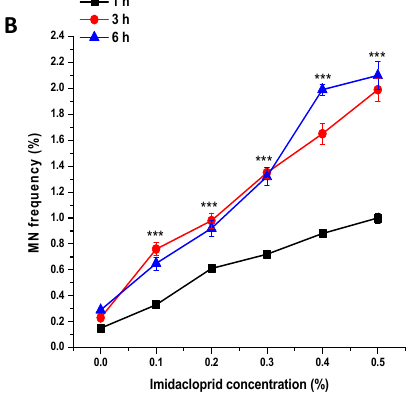
Figure 6. Micronucleus frequency in pollen-mother cells of P. sativum seeds treated with different concentrations of ( A ) methomyl (ME) and ( B ) imidacloprid (IM) for 1, 3, and 6 h. Data are means of three replicates ± SE. *** p < 0.001 compared to control at respective time interval.